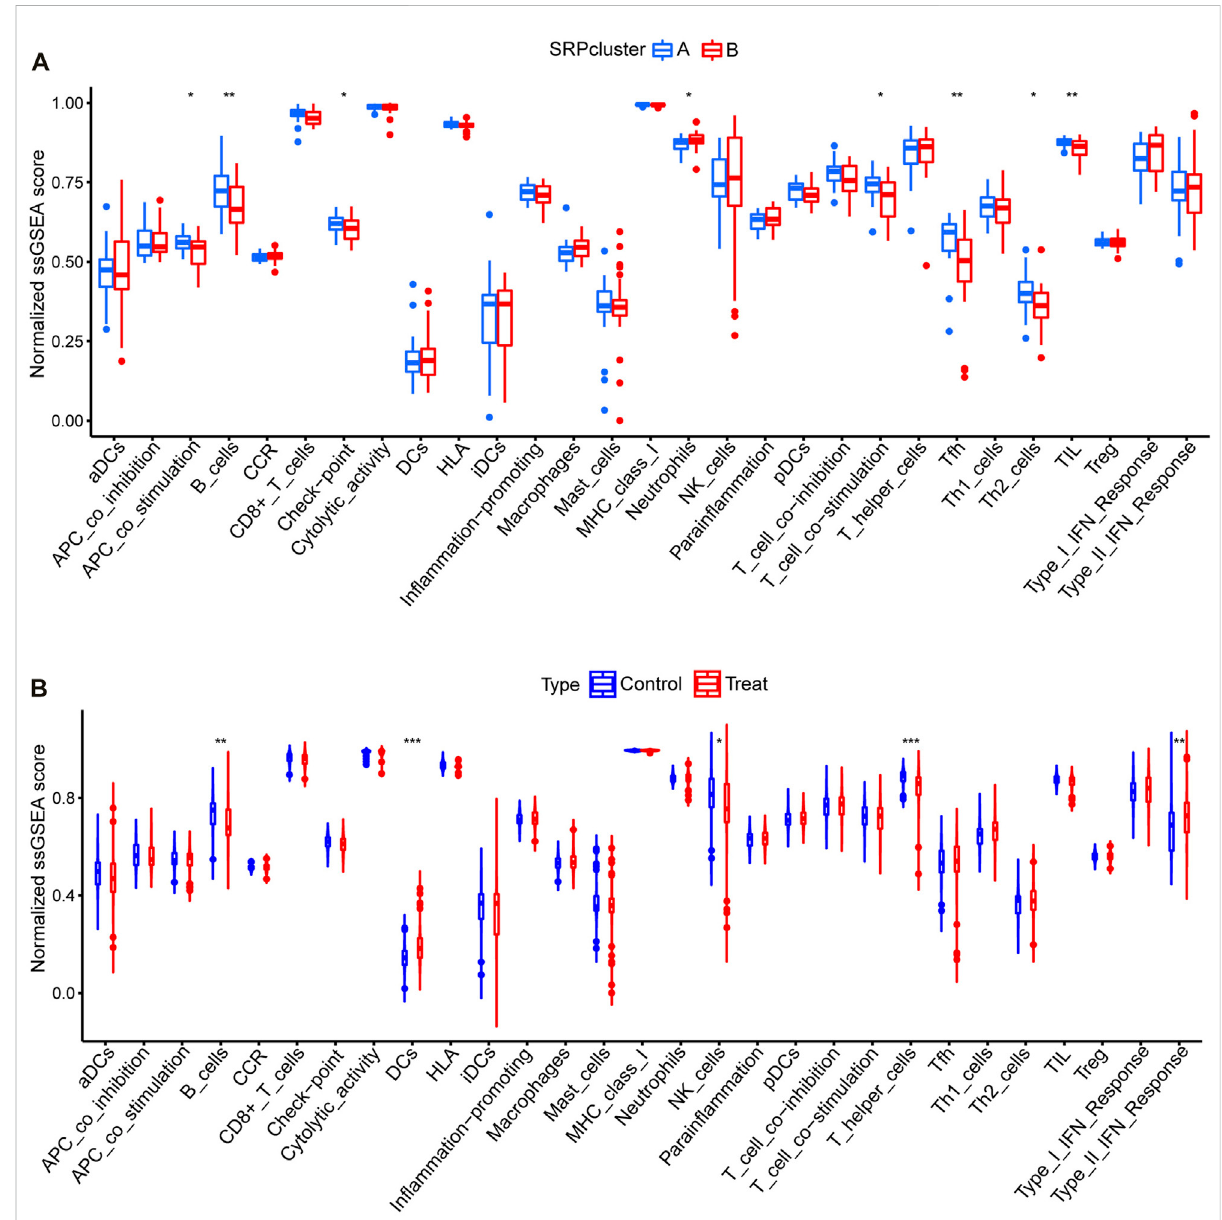
FIGURE 5 ssGSEAfor29immunegenesets. (A) ComparisonofnormalizedssGSEAscoresof29immunegenesetsbetweenSRPclusterAandSRPclusterB. (B) Comparison of normalized ssGSEA scores of 29 immune gene sets between treatment and control groups. *, p < 0.05; **, p < 0.01; ***, p <